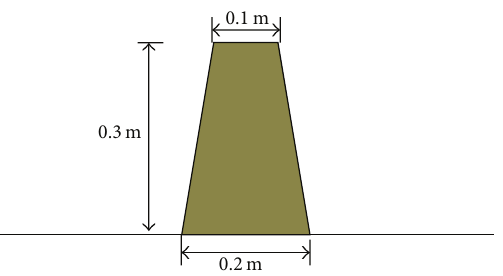
Figure 1: The initial configuration of the placement for slump flow.